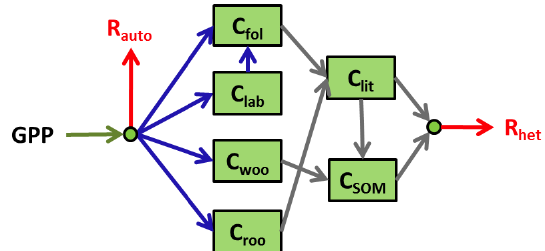
Figure A1. Schematic of the carbon fluxes in DALEC2. The green arrow indicates the gross primary production (GPP). Red arrows represent respiration fluxes: autotrophic respiration ( R auto ) and het- erotrophic respiration ( R het ). Blue arrows represent C allocation to the labile (C lab ), foliar (C fol ), wood (C woo ) and fine root (C roo ) pools. Grey arrows represent the litterfall and decomposition fluxes to the litter (C lit ) and soil organic matter (C som )